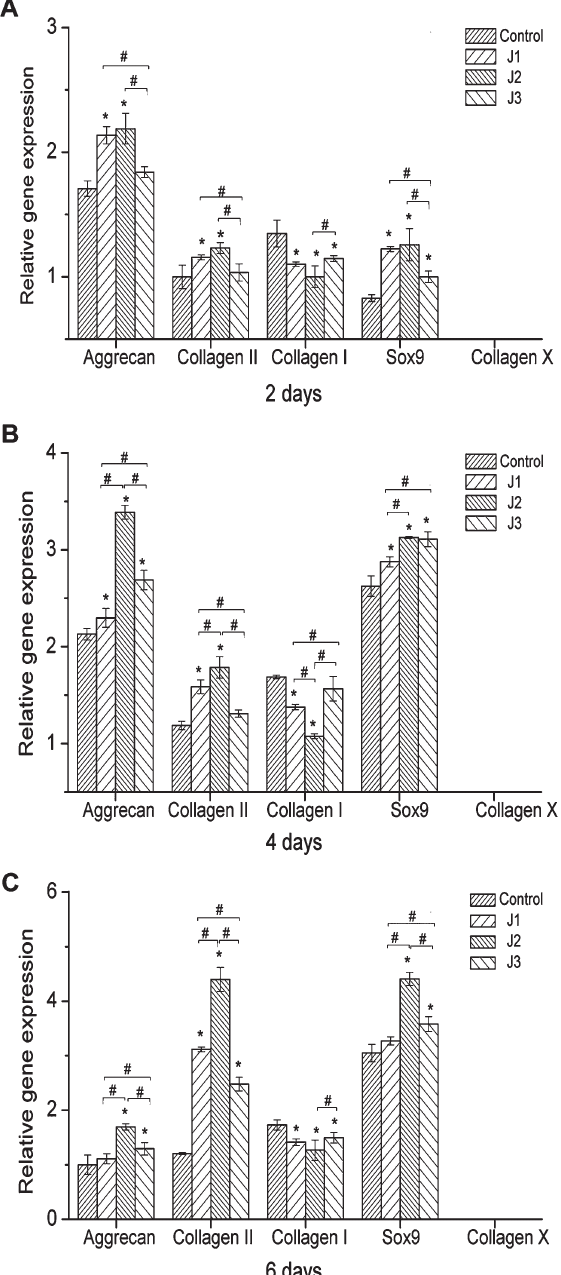
Figure 9. Quantitative comparison of extracellular matrix-related gene expression by quantitative real-time polymerase chain reaction. The chondrocytes were cultured with 0 (control), 0.125 (J1), 0.25 (J2), and 0.5 m g/mL (J3) JJYMD-C for 2 days ( A ), 4 days ( B ), and 6 days ( C ) (n=3 for each experiment). The levels of gene expression in media containing JJYMD-C were analyzed by the 2- DD CT method, and glyceraldehyde-3-phosphate dehydrogenase was used as internal control. Data are reported as means±SD of three independent culture experiments. *P , 0.05 compared to control; # P , 0.05 comparisons as indicated (one-way ANOVA followed by the Dunnett post hoc